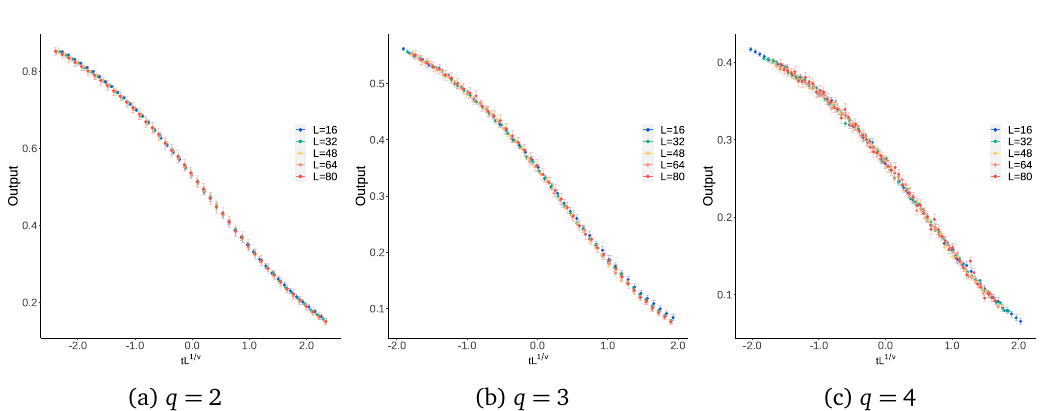
Figure 18: The finite-size scaled plots of the average output of an ensemble of 10 independently trained ANNs – training with MC data of the ferromagnetic square- lattice Ising model, and testing with MC data of the ferromagnetic q -state Potts model on a triangular lattice. The error bars shown are 99.7% confidence intervals of the ensemble average.